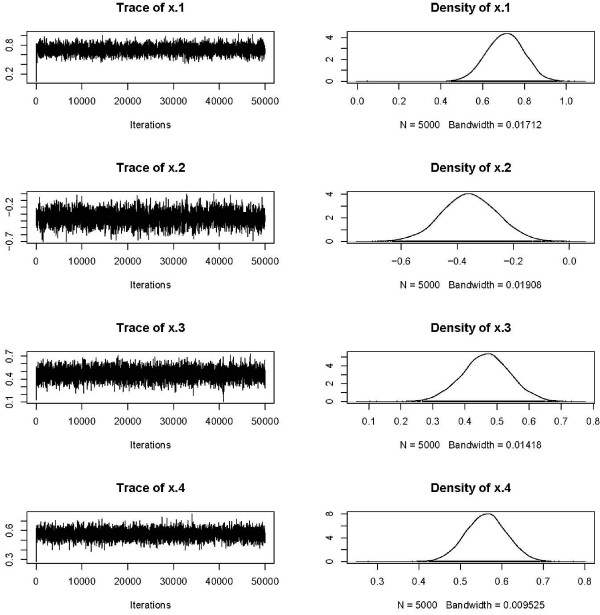
Traces of the regression coefficients β; 100 clusters, rate and shape of the frailty gamma distribution q = 1.